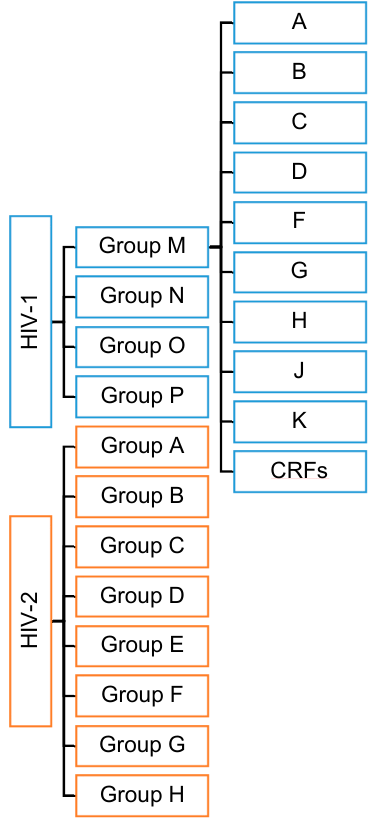
Figure 1. HIV types and strains classification.